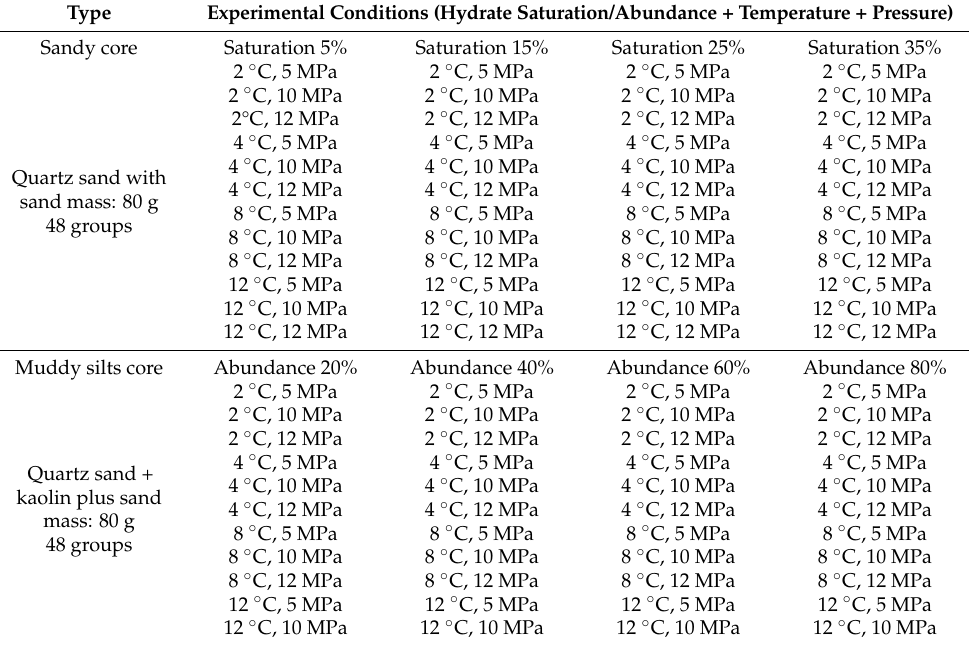
Table 4. Experimental schedule for core preparation and parameter